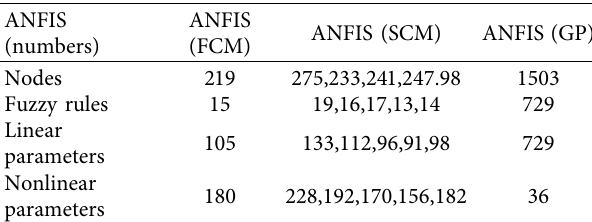
Table 2: Parameters of ANFIS